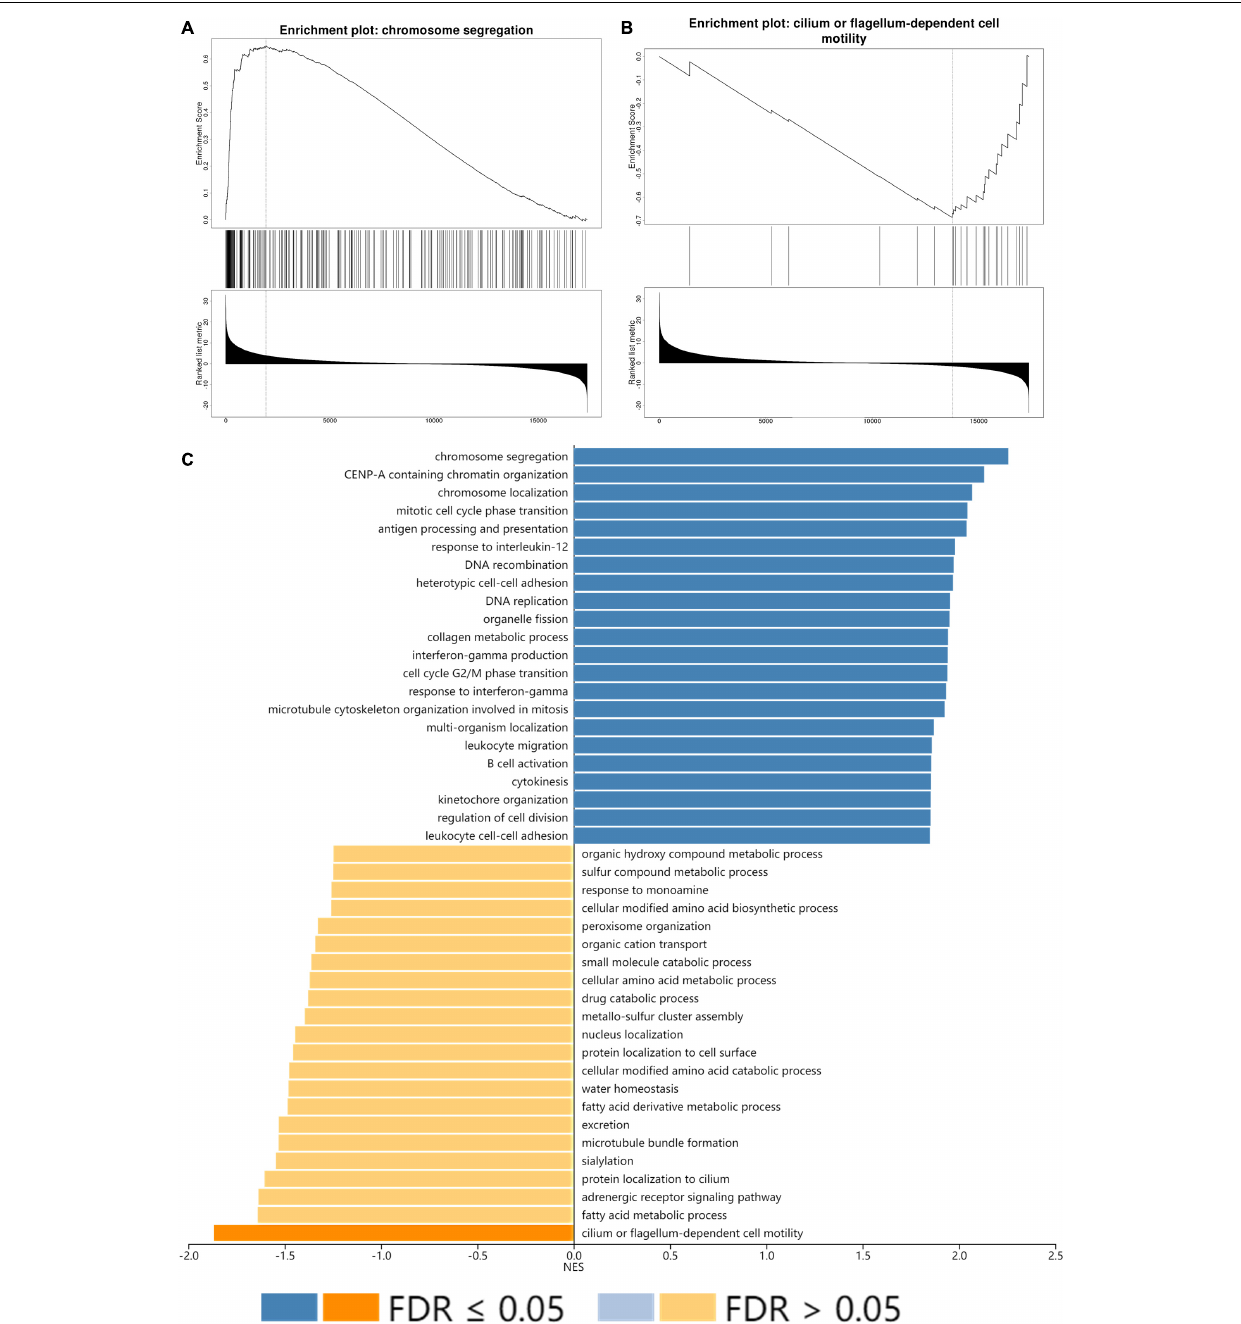
FIGURE 8 | GSEA enrichment analysis of SLC15A4. (A) Highest positive Net Enrich Score (NET). (B) Lowest negative Net Enrich Score (NET). (C) GSEA result of the top 22 positively and negatively enriched GO terms with FDR (false discovery rate). The blue bar indicates positively enriched terms, and the yellow bar represents negatively enriched